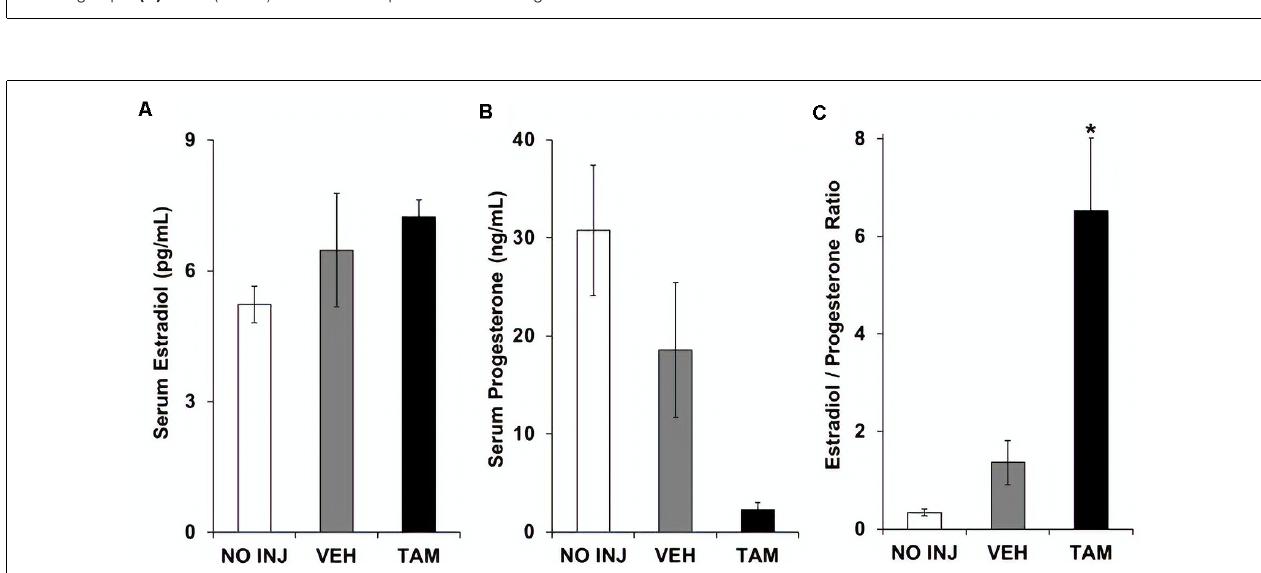
FIGURE 4 | Tamoxifen was associated with an increased ratio of serum estradiol to serum progesterone. (A) Mean ( ± SEM) serum estradiol concentration in the no-injection (NO INJ, n = 14), vehicle (VEH, n = 12), and tamoxifen (TAM, n = 11) groups. (B) Mean ( ± SEM) serum progesterone concentration. Despite a significant overall effect of group ( P = 0.006), Dunnett-corrected pair-wise comparisons to the VEH group were not significant due to a high level of variability in this group. (C) Mean ( ± SEM) ratio of estradiol to progesterone. ∗ Significant difference between the VEH and TAM groups ( P <